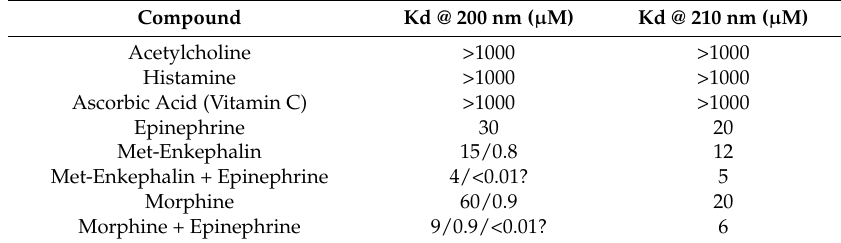
Table 3. Binding constants (in micromoles) of bioactive compounds, alone and in combinations, to the intact, purified mu opioid receptor (muOPR) measured at 200 and 210